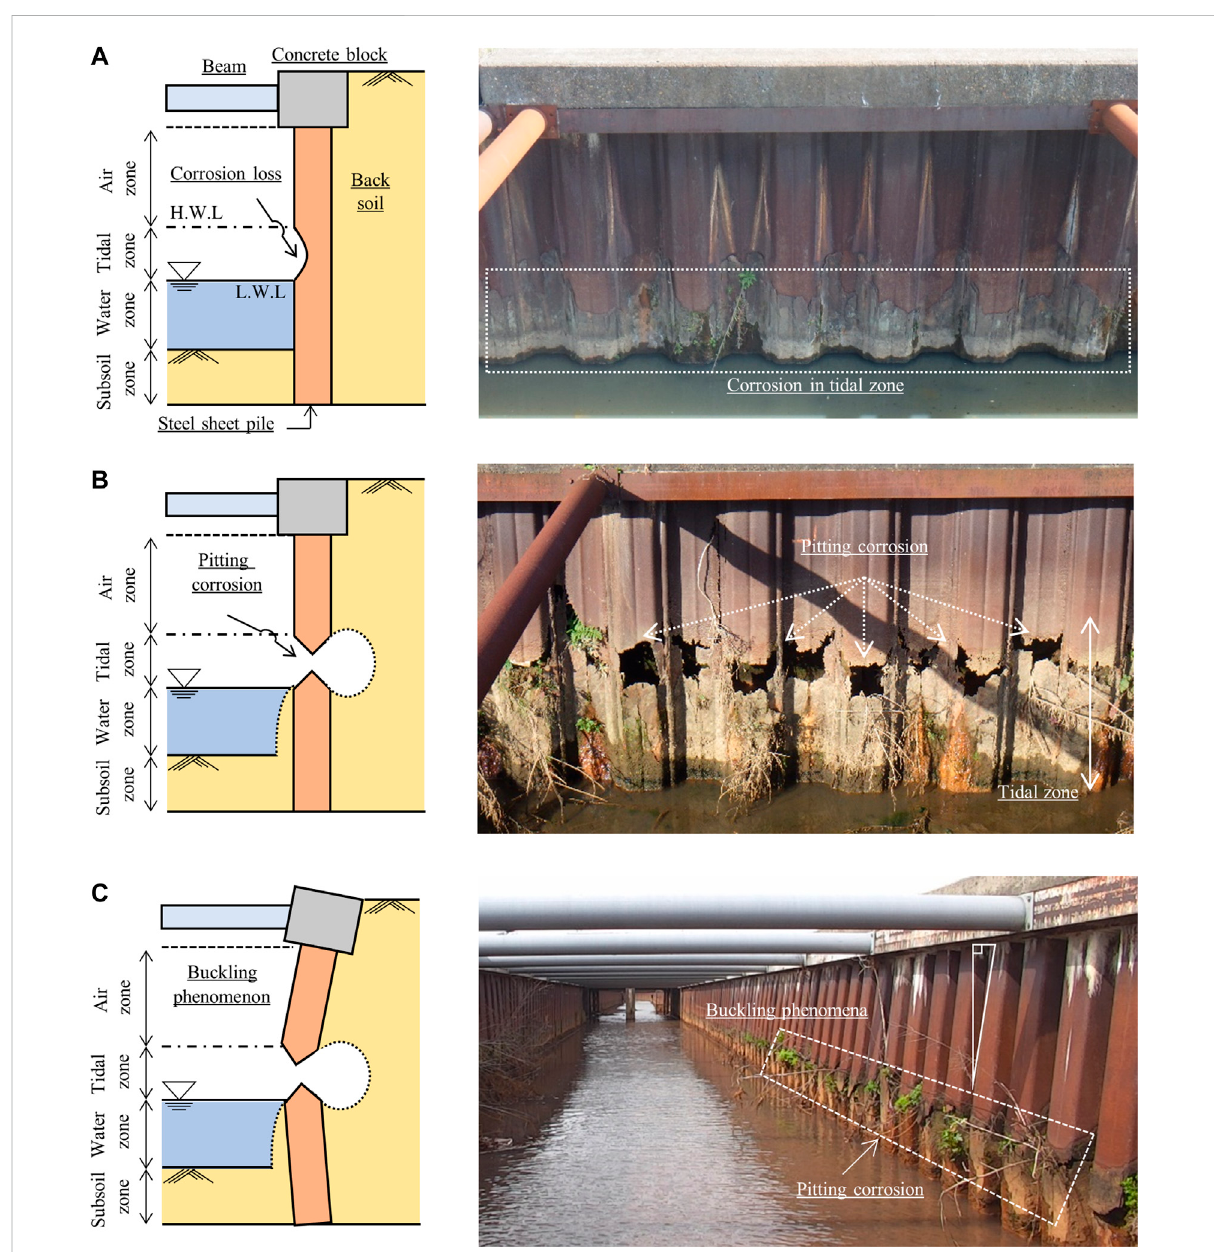
FIGURE 2 Bucklingprocessduetoextremecorrosioninservicesteelsheetpilecanals. (A) Acceleratedcorrosioninthetidalzone. (B) Extremecorrosionas pitting corrosion. (C) A buckling